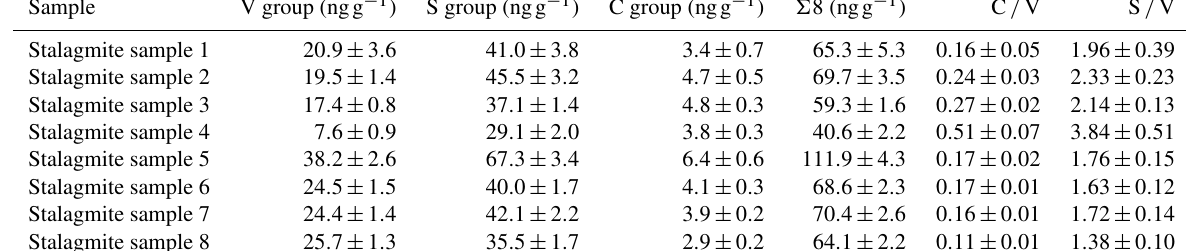
Table 4. Concentrations of the V-, S-, and C-group LOPs and the sum of all eight LOPs ( (cid:54) 8) inngg − 1 of the initial stalagmite samples and the ratios C / V and S / V. All samples are from stalagmite NG01 from the Herbstlabyrinth-Advent Cave. Sample